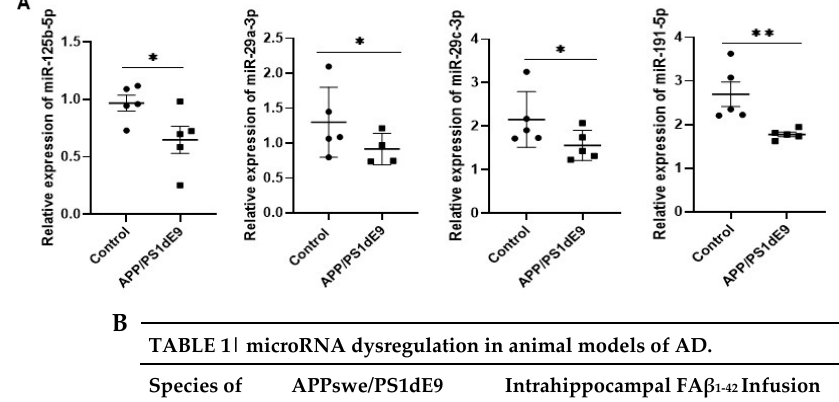
TABLE 1| microRNA dysregulation in animal models of AD.